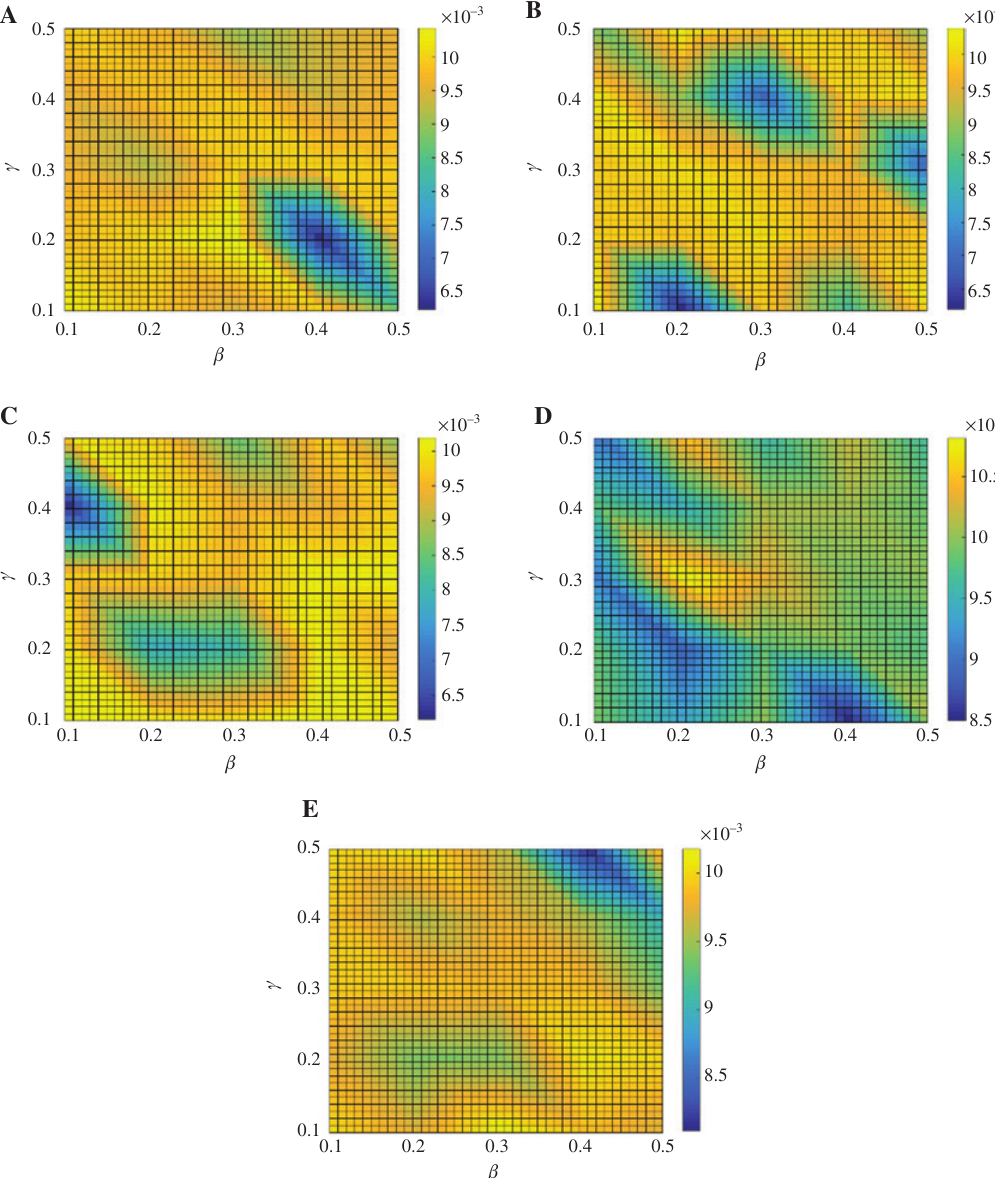
Figure 8: Estimation of Steam Pressure under Varying β and γ with the Reference of α as (A) 0.1, (B) 0.2, (C) 0.3, (D) 0.4, and (E)